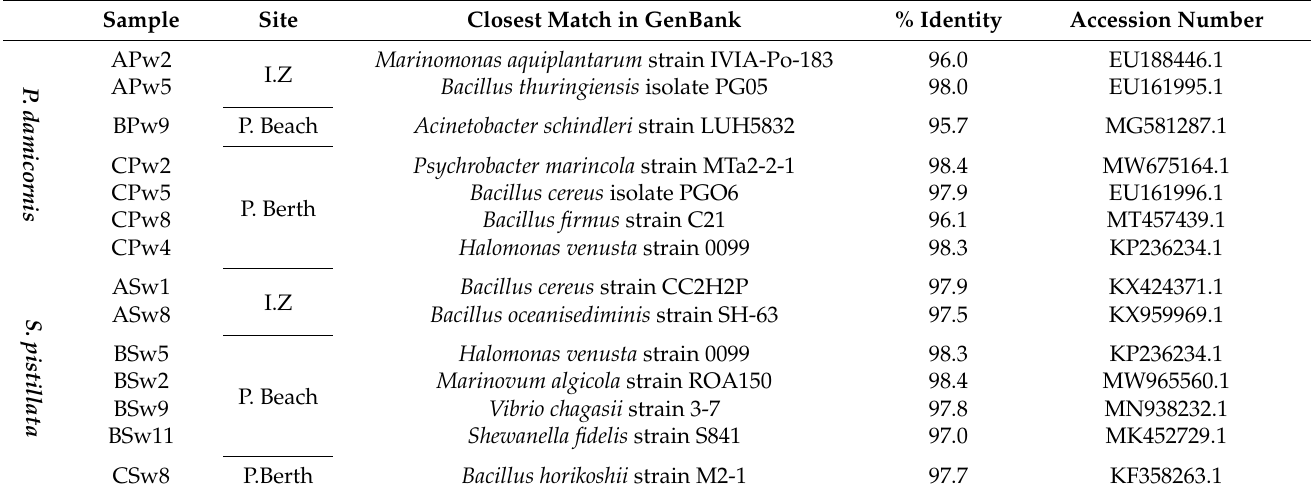
Table 2. Identification of bacterial isolates from seawater surrounding coral based on 16S rRNA gene